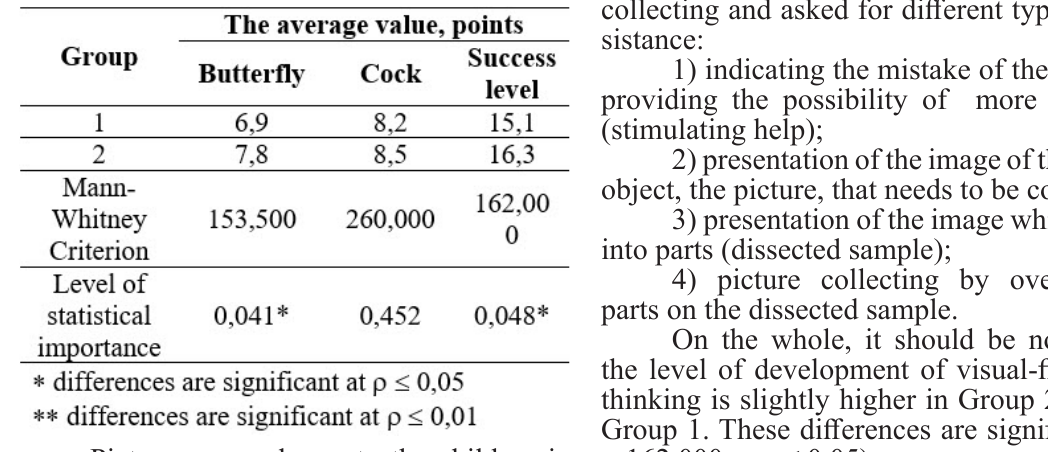
Table 2 . Features of visual-figurative thinking in children of senior preschool age